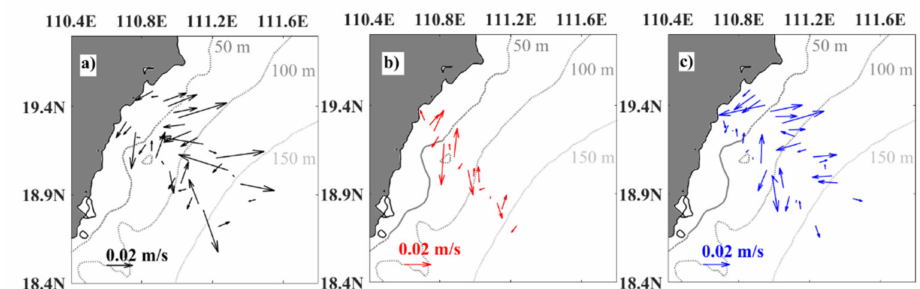
Figure 3. Distributions of tidal flow vectors without the typhoon ( a ), before the typhoon ( b ), and after the typhoon ( c ). Gray dashed lines represent isobaths.